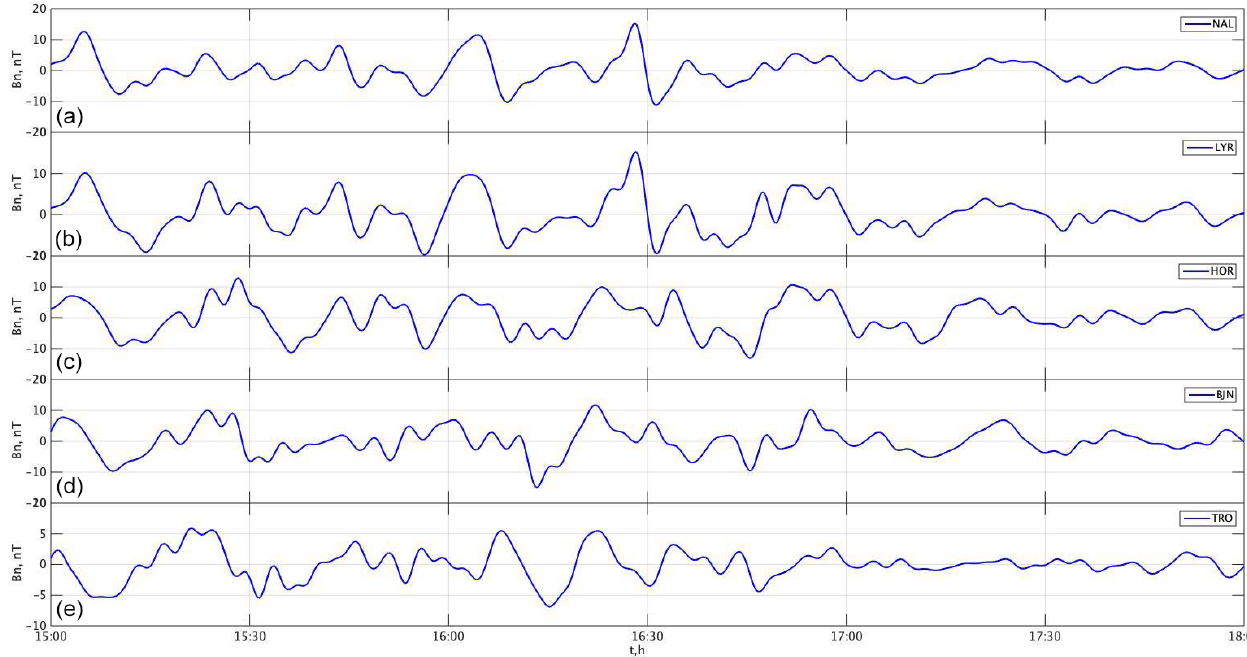
Figure 3. A latitudinal profile of geomagnetic pulsations registered on Svalbard (a–d) and in Tromsø (e) .